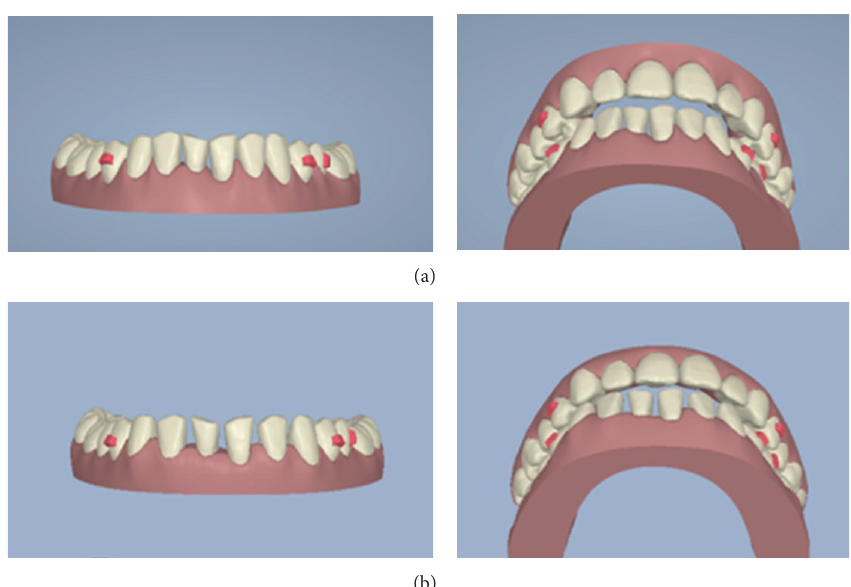
Figure 6: ClinCheck views demonstrating the different proposed treatment plans. (a) Treatment plan no. 1: close all spaces in lower anterior region and accept the TSD tooth size discrepancy. (b) Treatment plan no. 2: evenly distribute spaces between lower incisors to correct the TSD tooth size